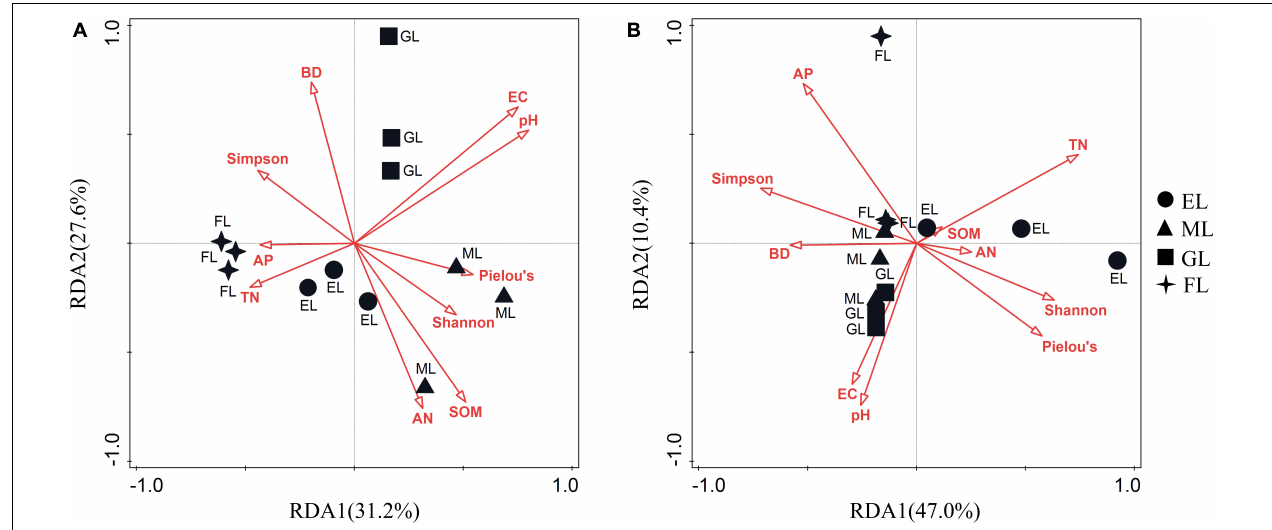
FIGURE 5 | Redundancy analyses (RDA) of pooled data on bacterial (A) and fungal (B) communities with biotic and abiotic variables. The red vectors represent trajectories of environmental parameters as independent variables. EL, exclosure; ML, mowed land; GL, grazed land; and FL,